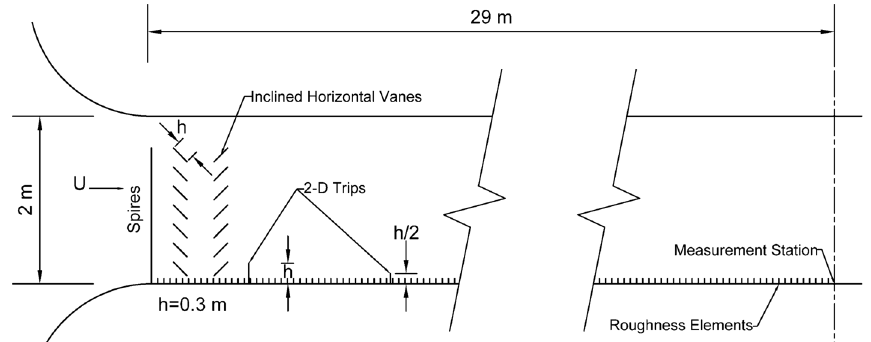
Fig. 3 Vibrating wing grid device of the atmospheric boundary layer (ABL) of Colorado State University